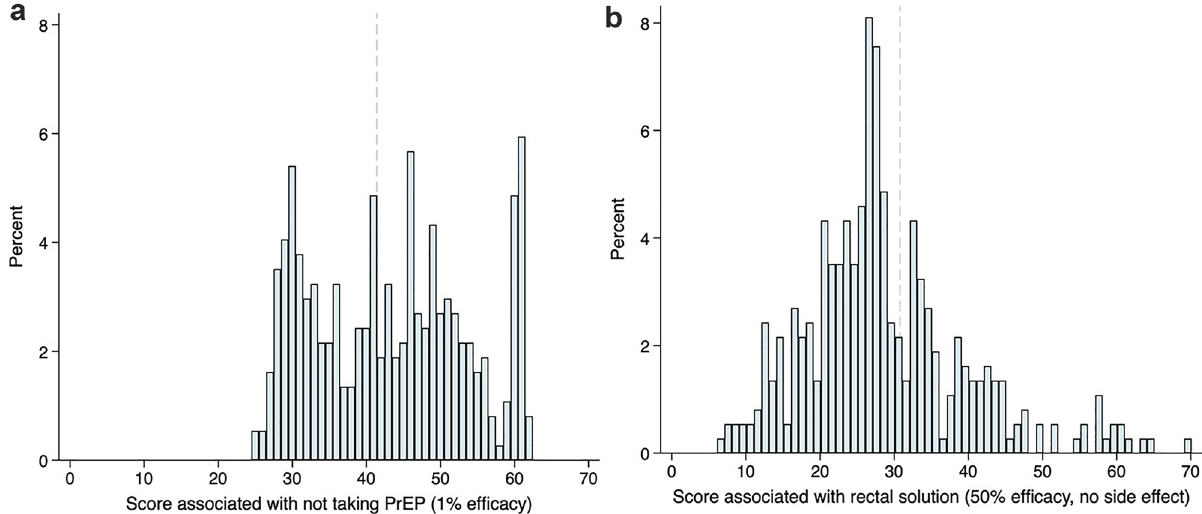
Figure 2. Heterogeneity in utility scores for Usual Care (no PrEP) and for rectal gel as PrEP. Distribution of predicted individual rescaled utility scores for Usual Care (not taking PrEP, panel A ) and for a rectal gel (panel B